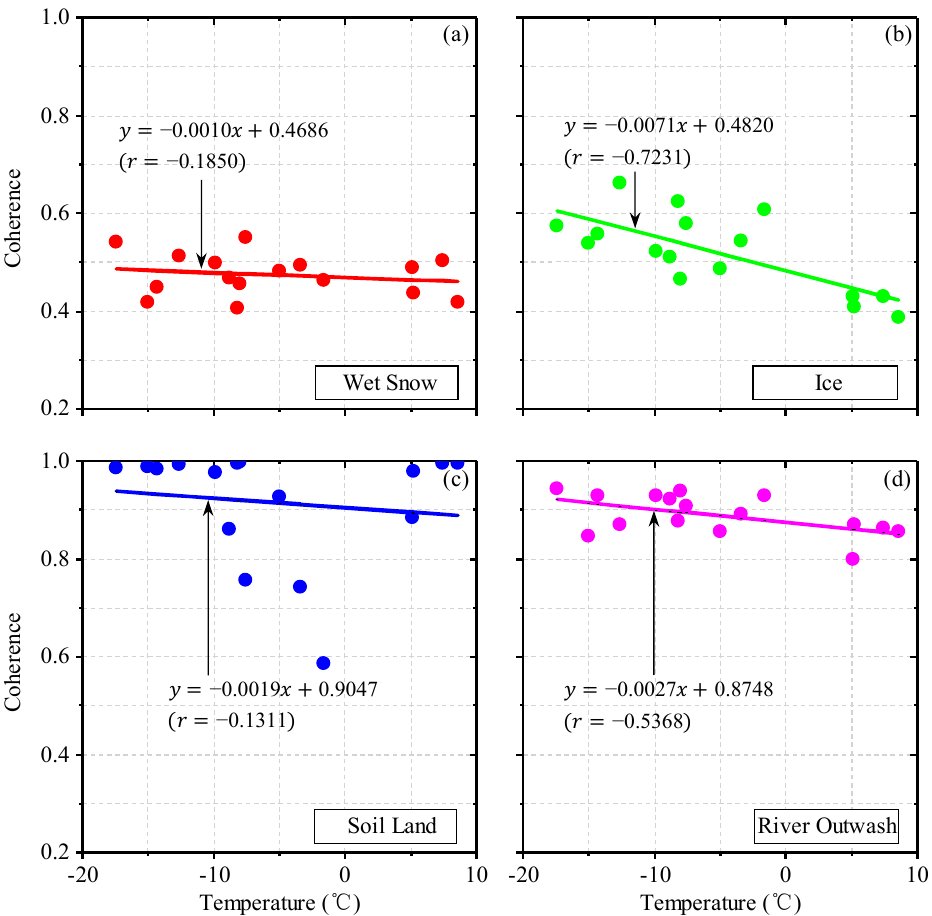
Figure 15. ( a – d ) show the resultant correlation relationship between the coherence mean and the temperature for the four classes, i.e., wet snow, ice, soil land and river outwash, respectively. Both the linear equation and the correlation coefficient are provided and marked for each class. The data points are denoted by dots, while the data-fitted linear equation is represented by a solid line.